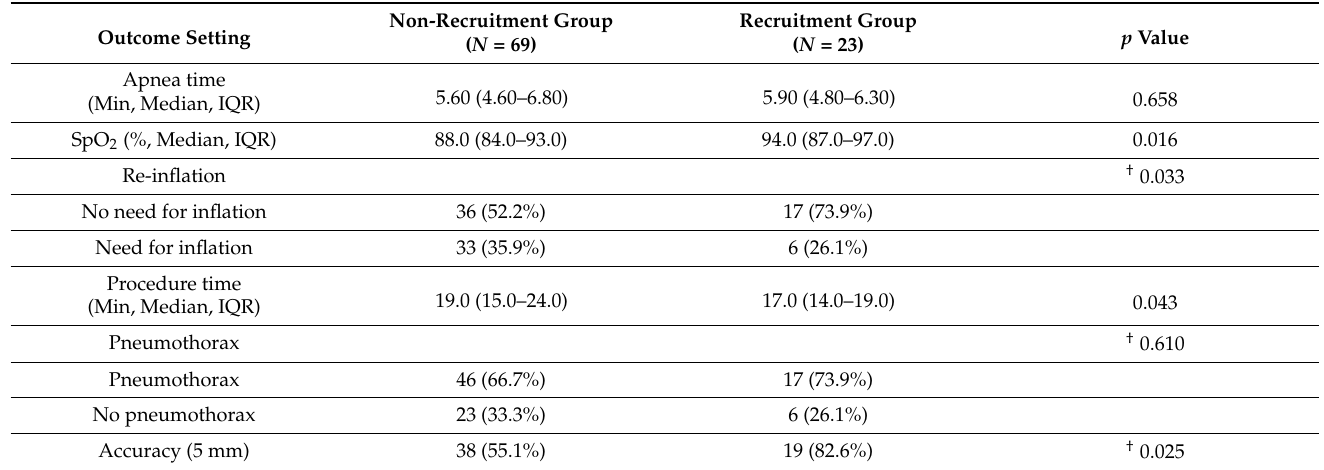
Table 2. Comparisons between the recruitment and non-recruitment groups.